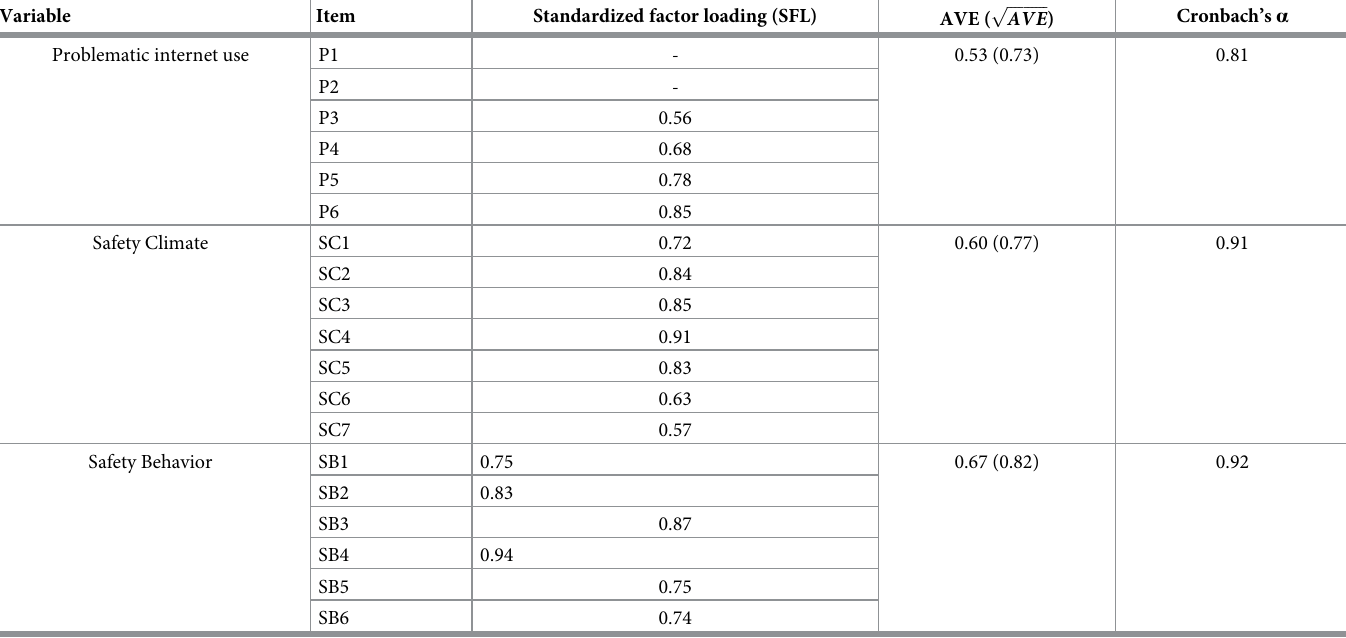
Table 2. Construct validity of problematic internet use (PIU), safety climate, and safety behavior.